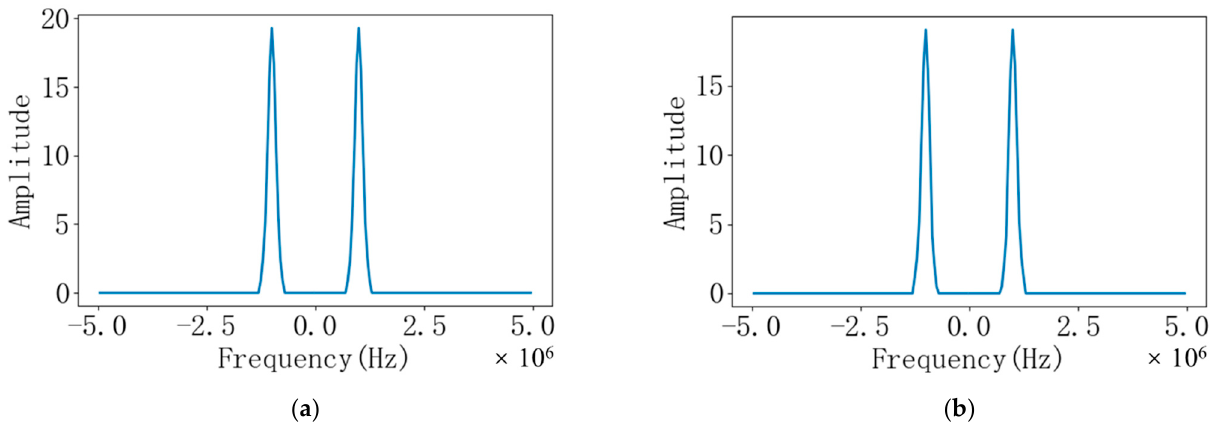
Figure 8. ( a ) Filtered bilateral spectrogram of downstream echo signal; ( b ) Filtered bilateral spectrogram of countercurrent echo signal.